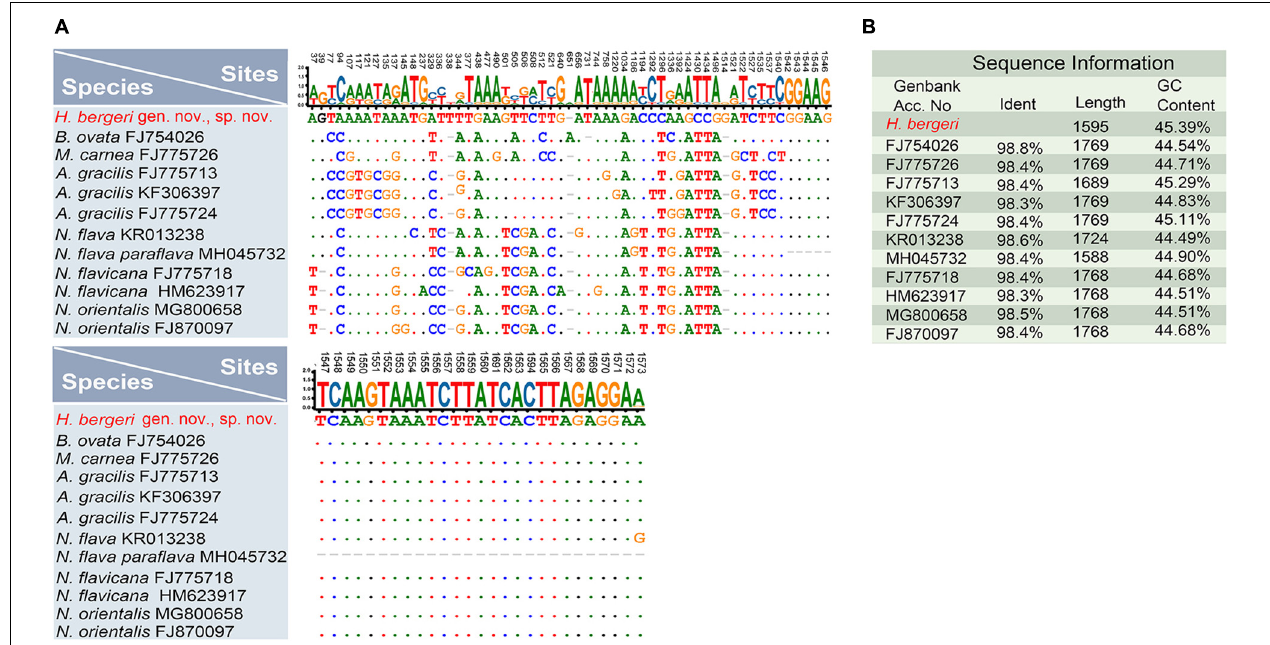
FIGURE 7 | Nucleotide differences and similarities between Heterobakuella bergeri gen. nov., sp. nov. (indicated in red) and other related species based on 18S rRNA gene sequences. (A) Positions of unmatched nucleotides; short lines (–) indicate the missing nucleotides and solid dots represent matched sites. (B) Sequence information including identity, length, and GC